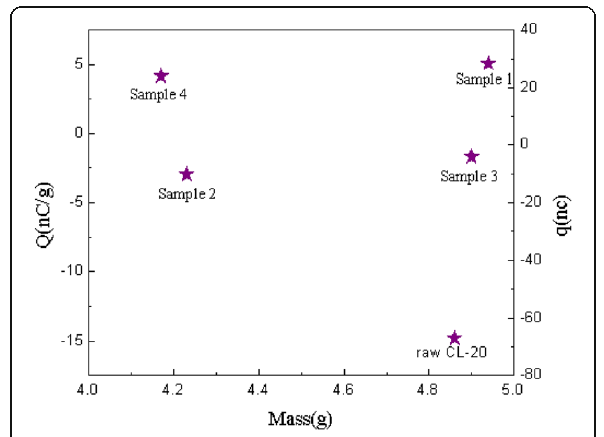
Fig. 4 DSC curves of samples